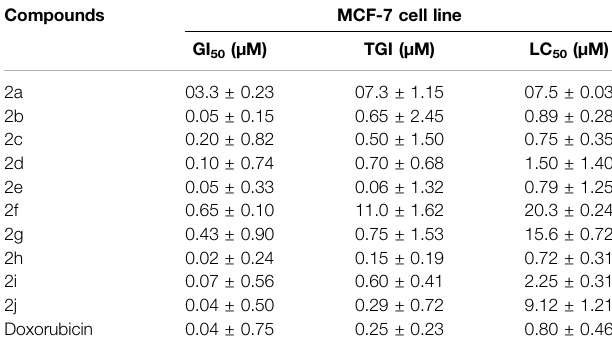
TABLE 1 | Anticancer activity of compounds (µM) (2a-2j).